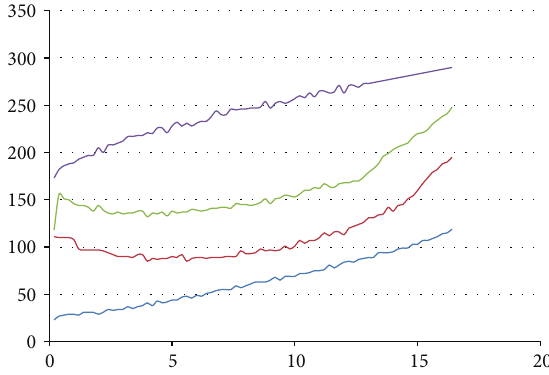
Figure 7: The fluorescent intensity of Output strands from exper- iment (A1). 𝑥 -axis is reaction time and 𝑦 -axis is the fluorescent intensity of 6-FAM. From bottom up, the curves correspond to cases of concentrations of Input strand, being 0nM (blue), 20 nM (red), 40 nM (green), and 80 nM (purple), respectively.